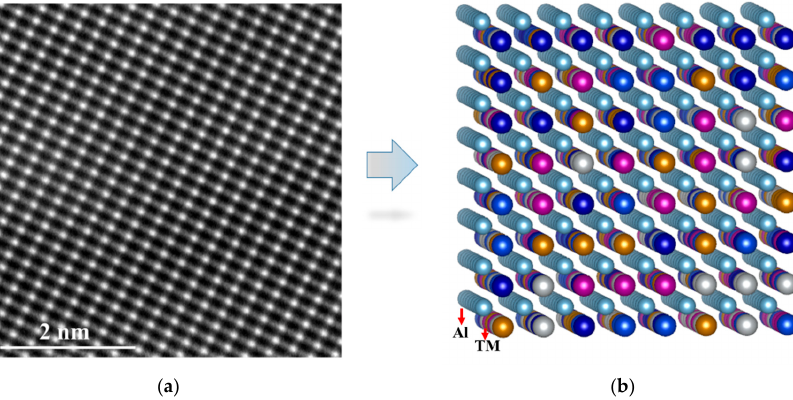
Figure 13. ( a ) Fourier-filtered atomic resolution HAADF-STEM image of the Al(CoCuFeMnNi) alloy. ( b ) Proposed unit cell showing the Al and (CoCuFeMnNi) transition metal sublattice. ( b ) Proposed unit cell showing the Al and (CoCuFeMnNi) transition metal